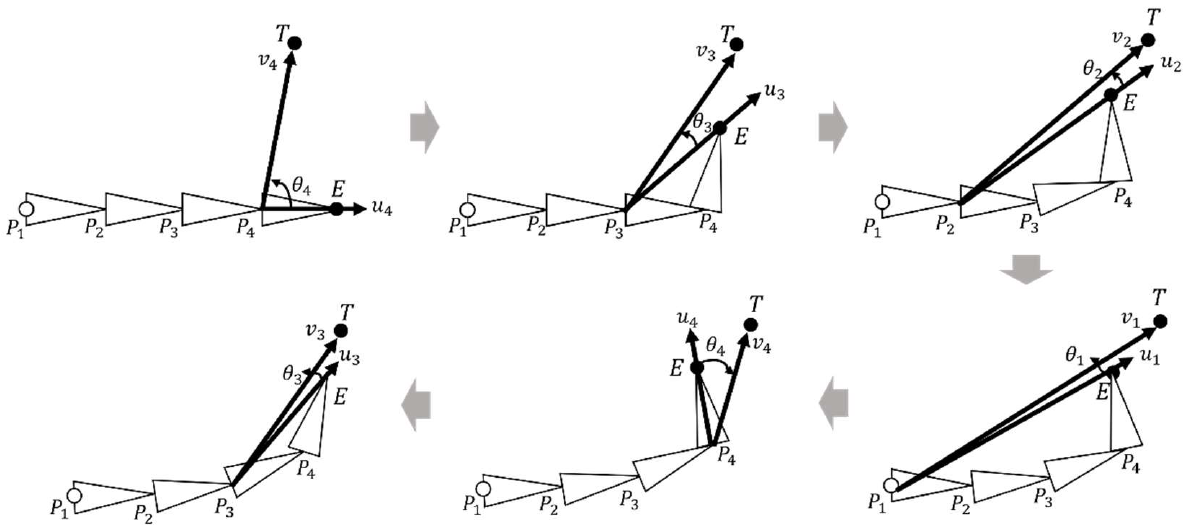
Figure 13. Procedure of CCD IK.